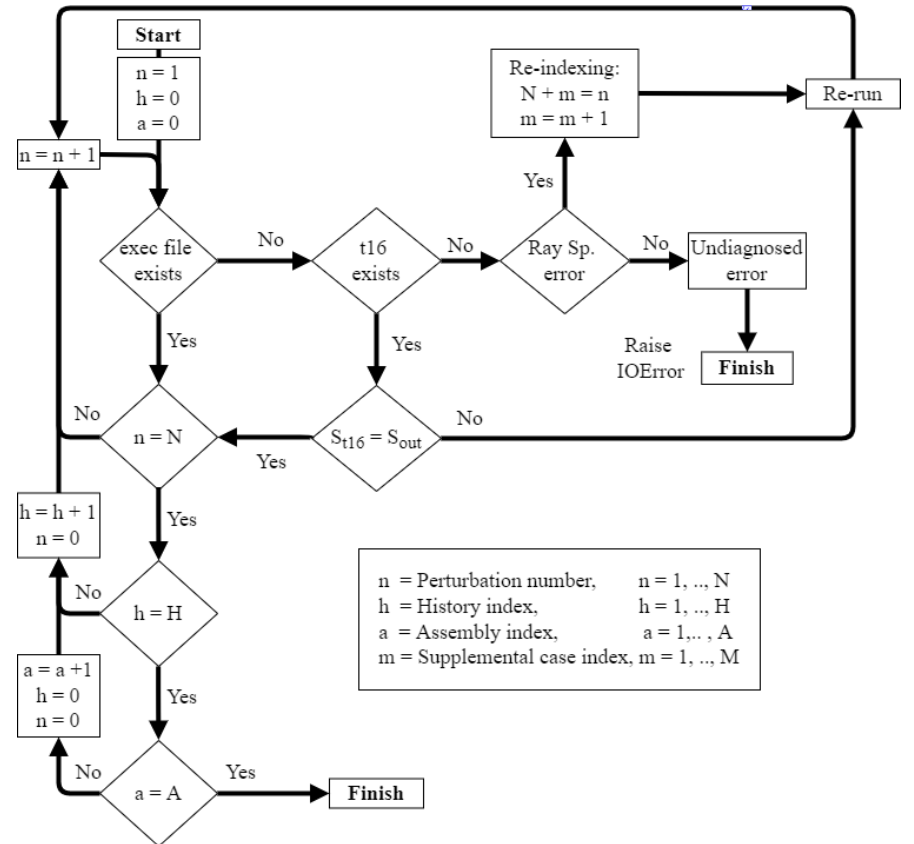
Figure 2. On-the-fly verification of Polaris library